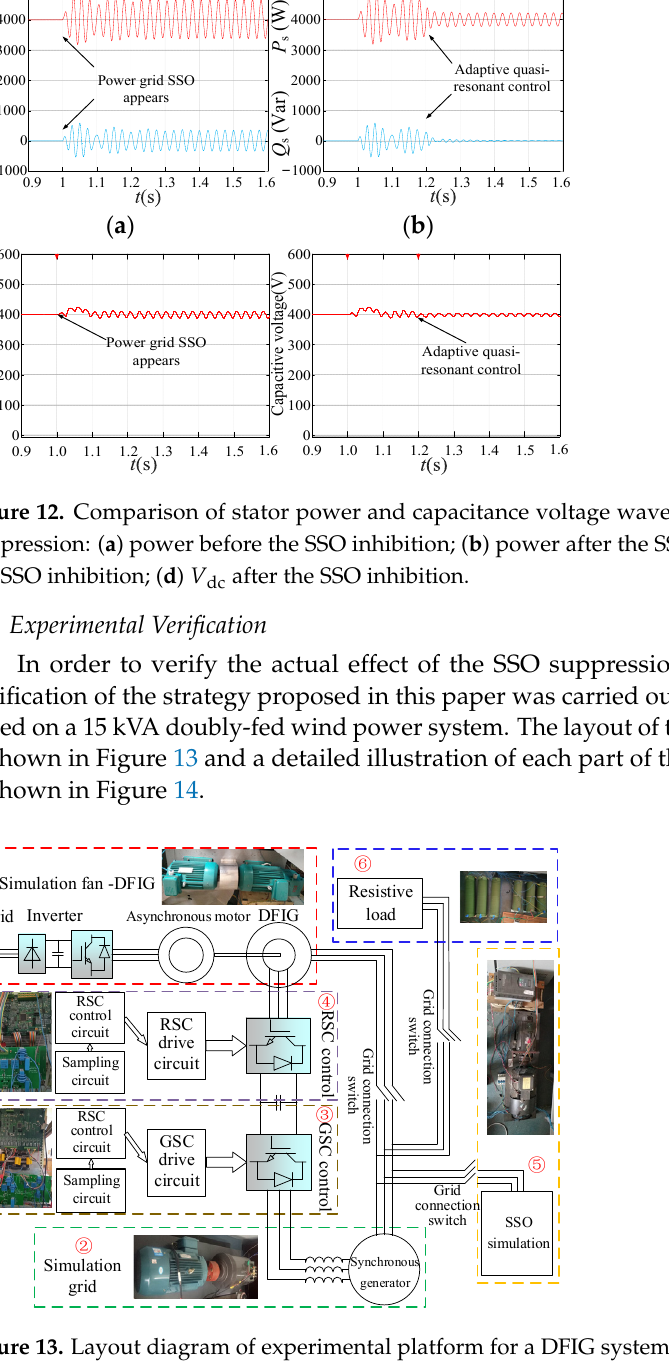
( d ) Figure 11. Comparison of inhibition effects between two resonant controllers with SSO frequency of 10 Hz: ( a ) quasi-resonant controller; ( b ) stator current single phase magnification; ( c ) adaptive quasi-resonant controller; ( d ) stator current single phase magnification. Finally, the DFIG stator power and capacitance voltage waveforms before and after SSO inhibition were observed. The expected values for the stator active power and reac- tive power were 4000 W and 0 Var, and the capacitance voltage was maintained at 400 V. As shown in Figure 12, when the power grid SSO was generated, both the DFIG stator side output power and the capacitance voltage oscillated, with the power oscilla- tion being the most severe. When the oscillatory inhibition strategy proposed here was adopted, the DFIG stator-side reactive power oscillation was basically suppressed and,